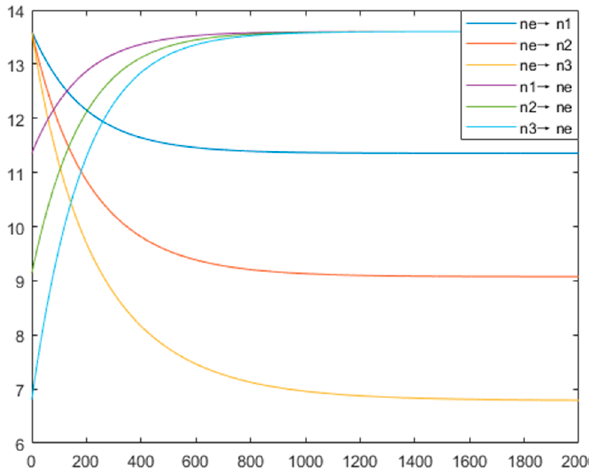
ff erent desired propeller revolution